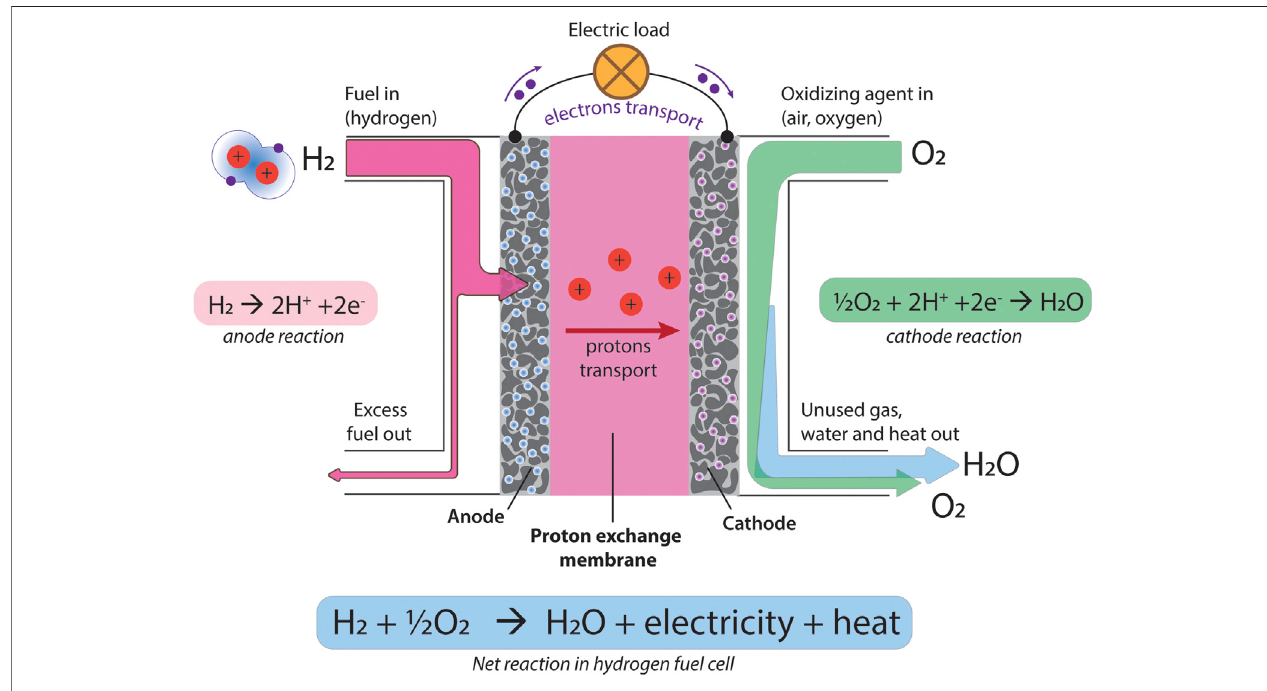
FIGURE 3 | Schematic representation of a hydrogen fuel cell, proton transport through the membrane, and the chemical reactions taking place at the anode (hydrogen oxidation reaction) and cathode (oxygen reduction reaction).